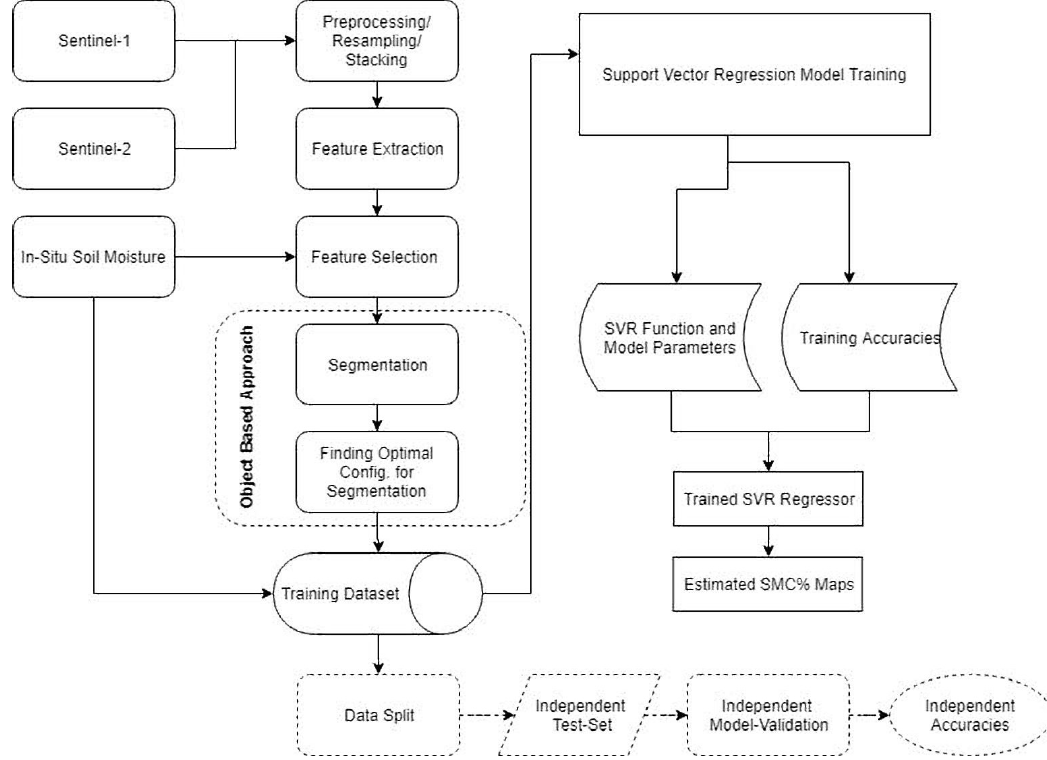
Figure 2. Proposed flowchart for soil moisture retrieval using the pixel- and object-based approach. SVR, support vector regression; SMC, soil moisture